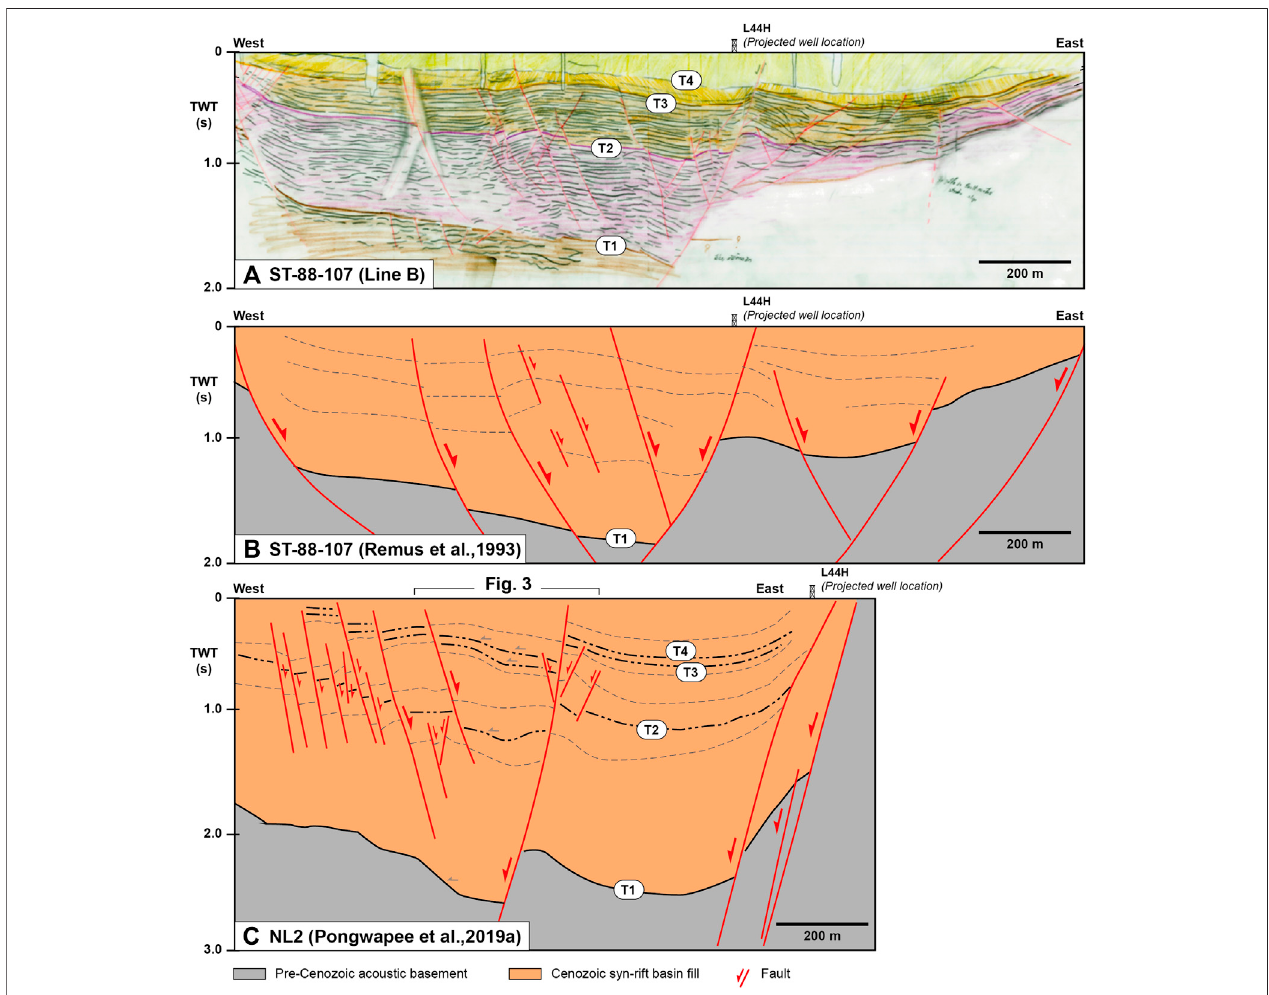
FIGURE2|(A) Exampleofseismicinterpretation ontracingpaperwith coloredpencils. (B) Seismic interpretation ofthesame2Dseismic linepublished by Remus et al. (1993). (C) Seismic interpretation based on 3D seismic data by Pongwapee et al. (2019a). See Figure 1 for line location.